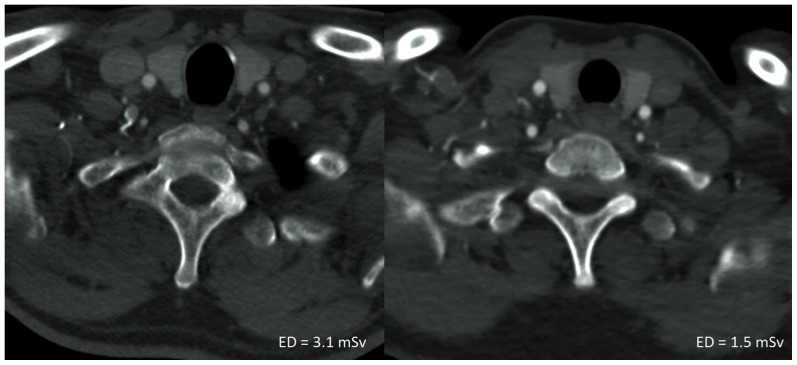
Comparison of image quality at the thoracic outlet.Axial images with similar window setting (W900/L250) using the standard protocol and FBP (A) and at low-dose, using SAFIRE for image reconstruction (B). Both studies were rated having excellent diagnostic image quality. Higher vessel attenuation and reduced image noise is evident at low-dose and SAFIRE (B).